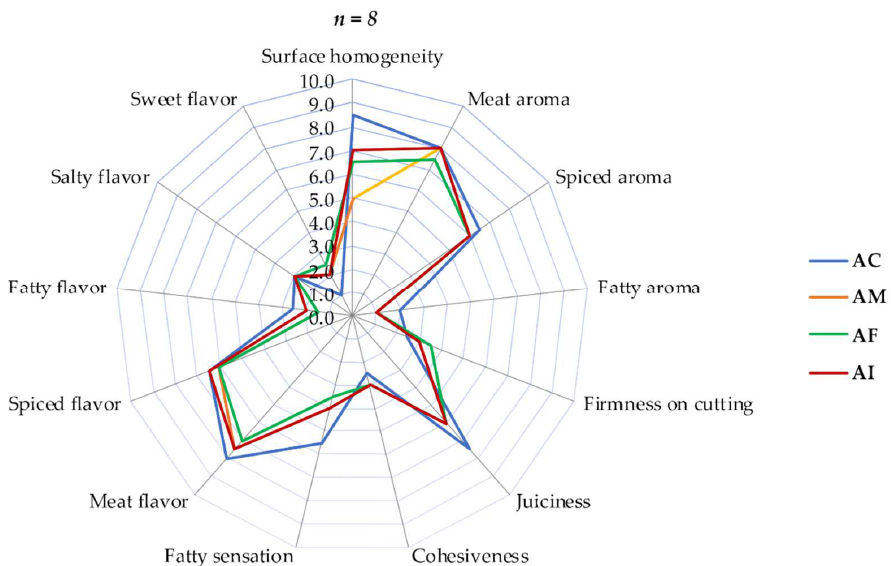
Figure 4. Sensorial profile of pork and chicken meatballs performed by semi-trained panelists ( n = 8). Control AC meatballs (full fat, no fiber added), meatballs with inulin AI (reduced fat and added inulin dissolved in water), meatballs with fructo- oligosaccharides AF (reduced fat and with added FOS dissolved in water), and meatballs with the AM mixture (reduced fat and added inulin mixture and FOS dissolved in water).